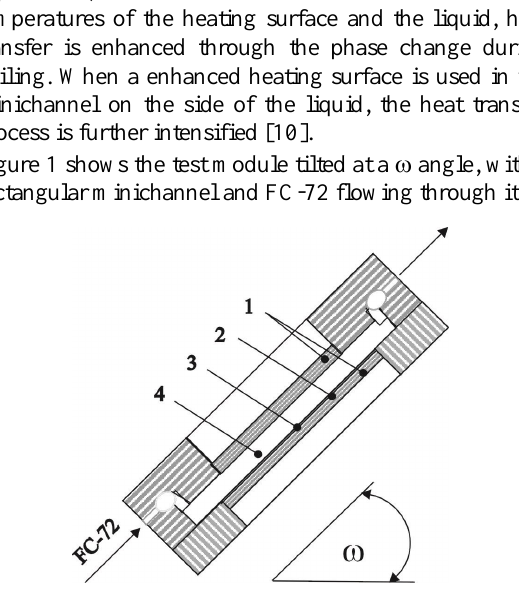
Fig.1 . Test module: 1- separating glass panes, 2- heating foil, 3- a layer of liquid crystals, 4- minichannel (illustrative figure, not to